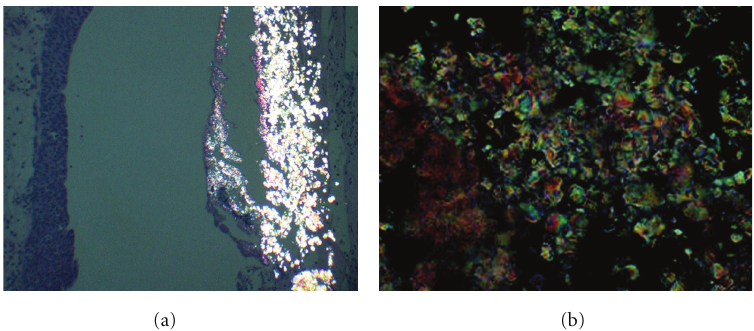
Figure 3: (a) shows widespread massive aggregate of CaOx crystals in the renal collecting system extending into the parenchyma seen under polarized light. (b) shows a region of (a) under high power showing accumulation of polygonal crystals with multicolored birefringence under polarized light. AON: acute oxalate nephropathy, CaOx: calcium